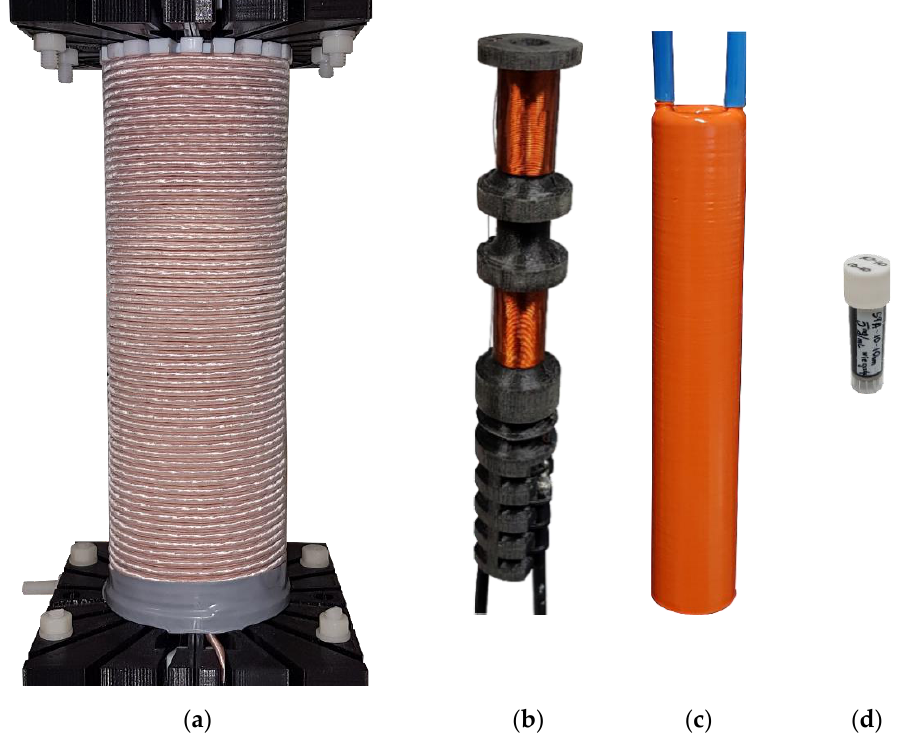
Figure 1. ( a ) The excitation coil ( b ) 3D-printed carcass for magnetic measurement ( c ) 3D-printed water-cooled support for calorimetric measurement ( d ) a 2 mL sample of the nanoparticle solution.